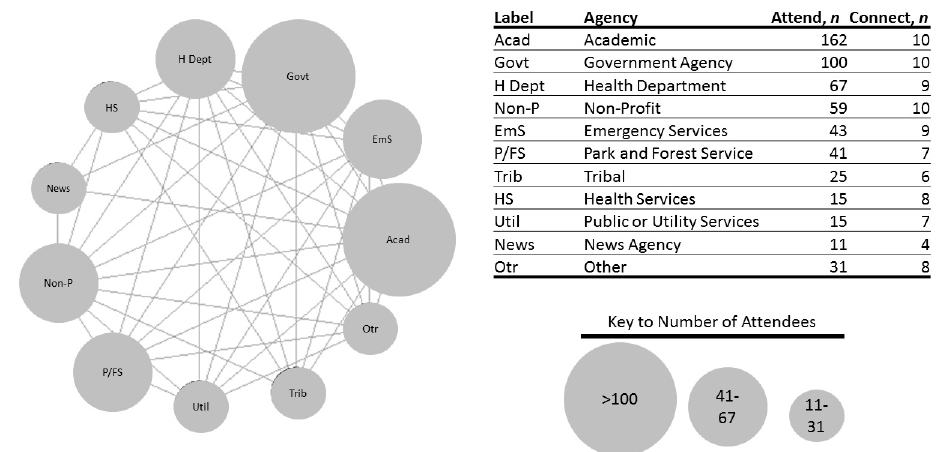
Figure 2. Bi-directional map of participants at 13 climate and health events from 2012–2018. The lines indicate that a member from the agency type attended a meeting with a member of another agency type. The size of the circles indicates the approximate number of participants attending all 13 events.